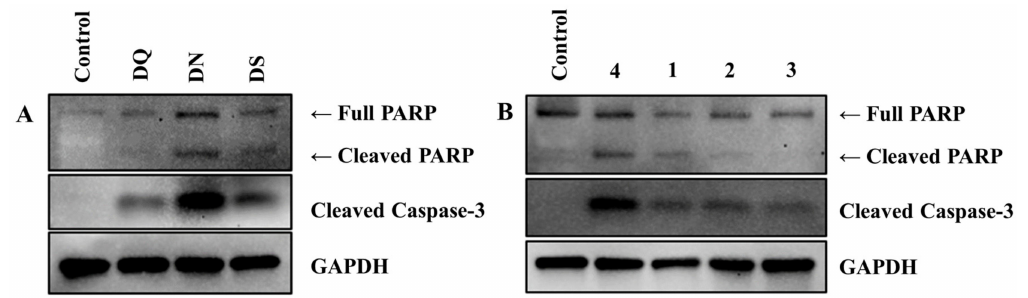
Figure 4. E ff ectiveness of DN against U2OS osteosarcoma cells. ( A ): U2OS cells treated with vehicle or 100 µ g / mL extracts for 48 h. Apoptosis indexes (Cleaved Caspase-3 and PARP) were detected via western blotting. GAPDH served as the internal control. ( B ): U2OS cells treated with vehicle or 5 µ M of each compound for 24